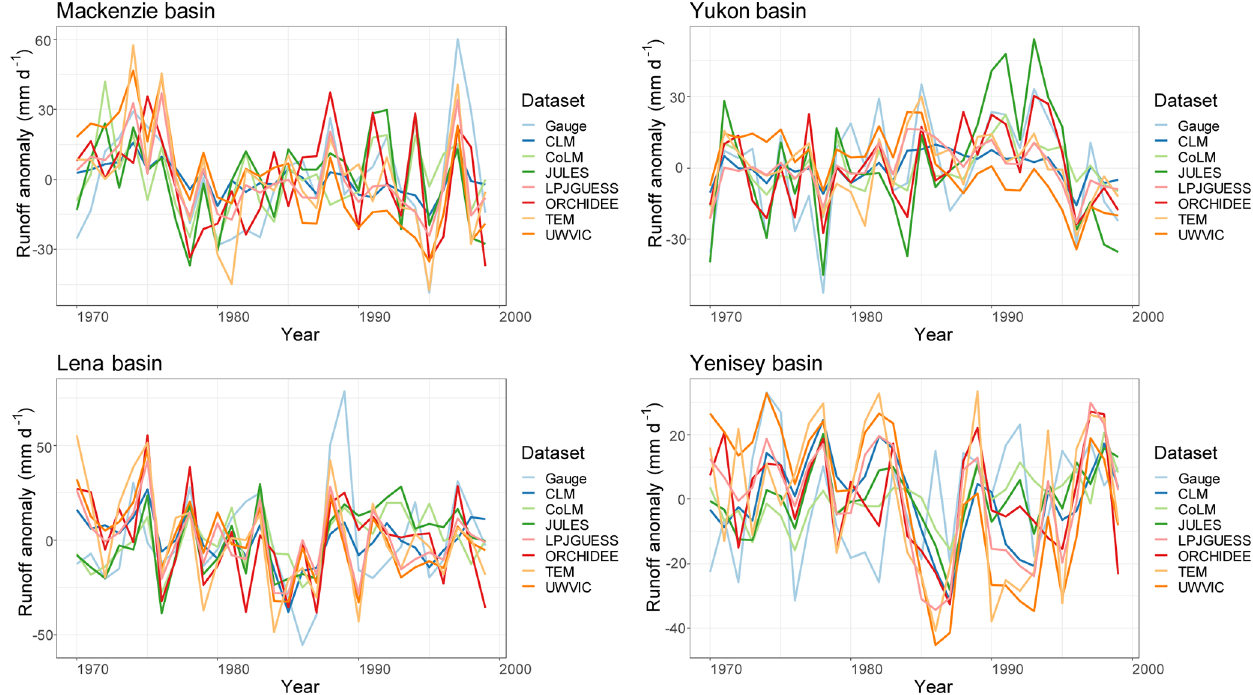
Figure 6. Runoff anomaly comparison between gauge data and models simulations for the period